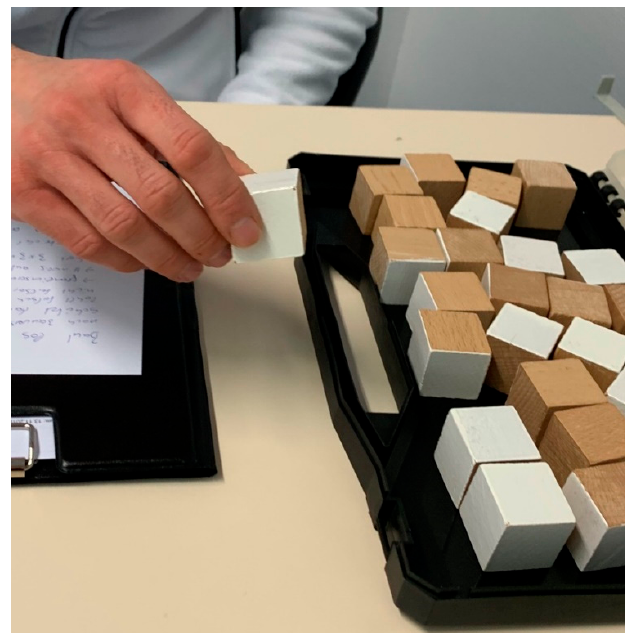
Figure 10. Typical box-block test that tests patients on spatial and logical construction solutions. The test asks the patient to place the blocks in an arrangement that leaves all the white facets at the surface, facing outwards.